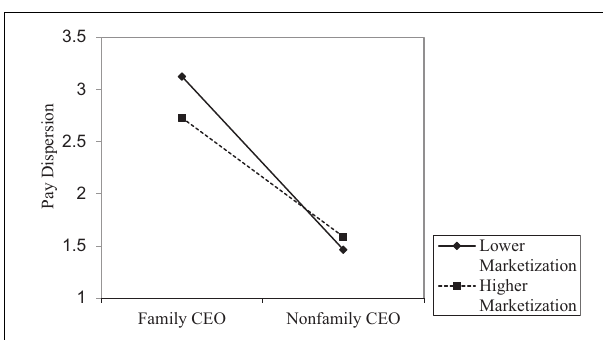
FIGURE 3 | The moderation effect by marketization